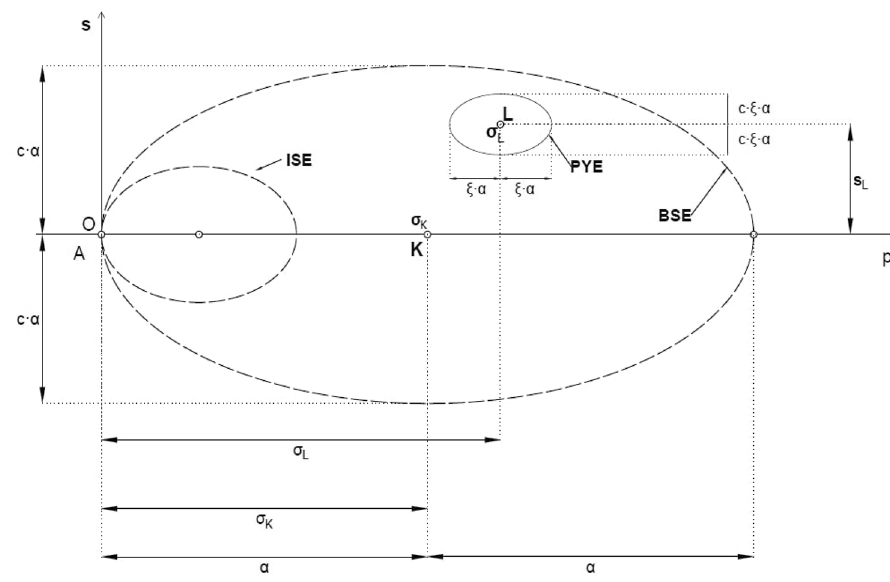
Fig. 1 Graphical representa- tion of the constitutive